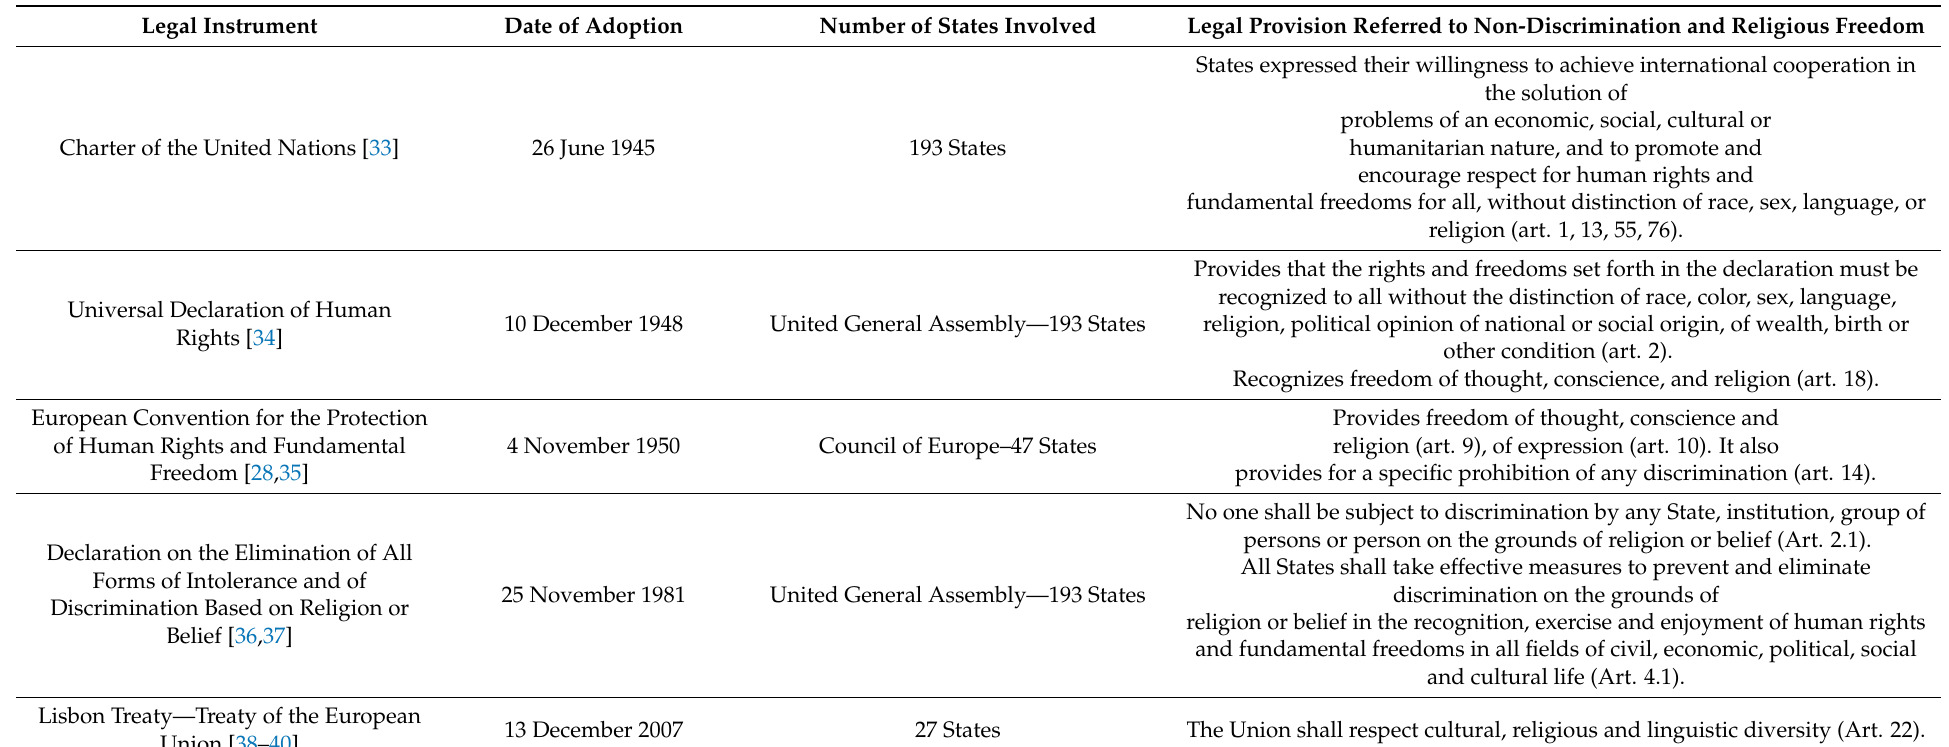
Table 1. Some of the most important legal instruments in the field of non-discrimination and religious freedom and